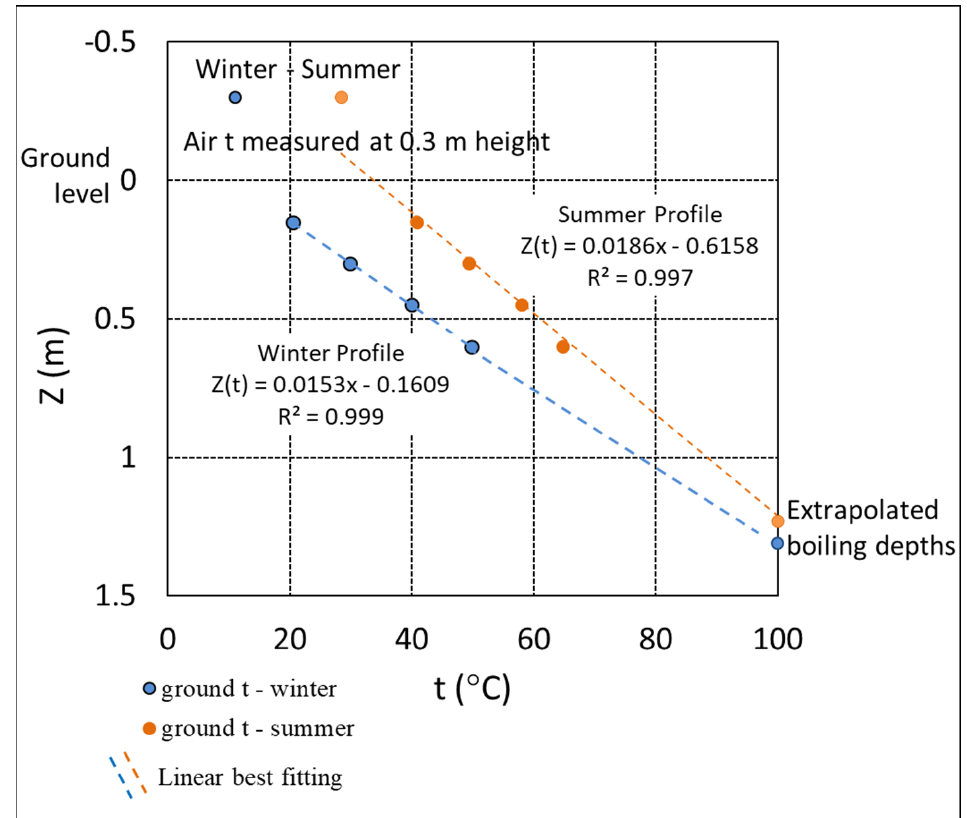
Figure 2. Two examples of simultaneous temperatures registered at the VSCS station in the air and in the ground profile. the ground